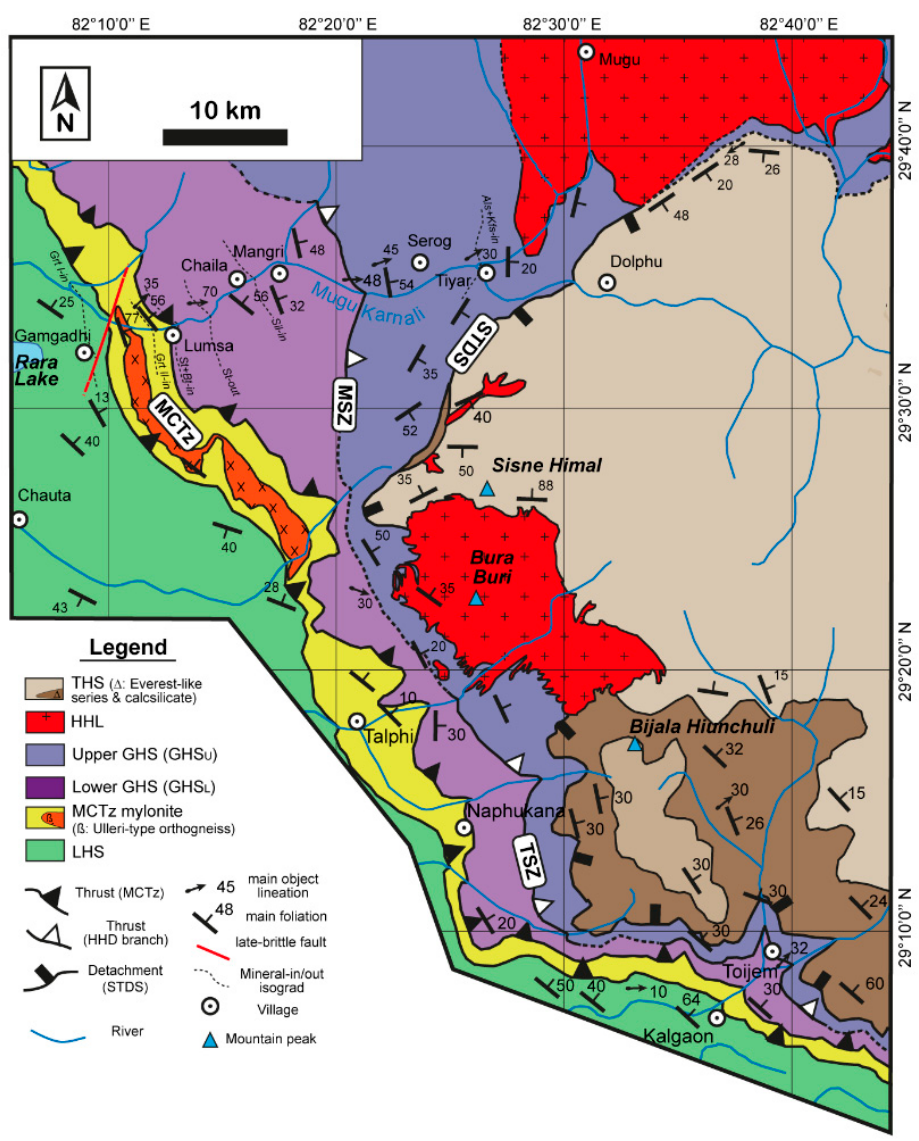
Figure 9. Geological map of Mugu Karnali and Lower Dolpo (western Nepal) [127].